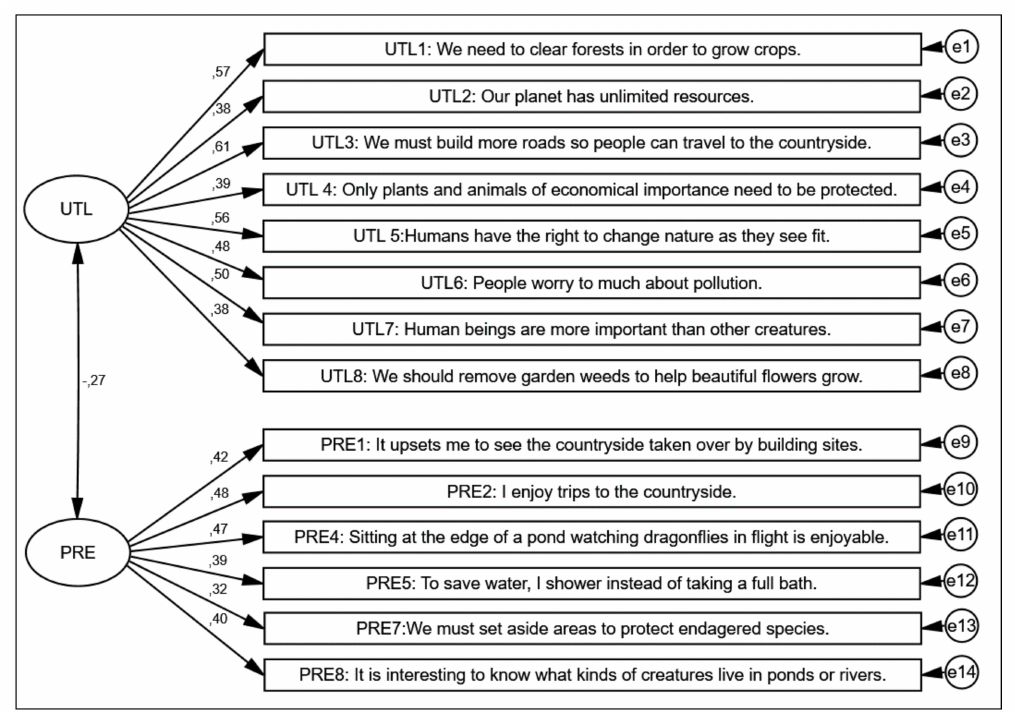
Figure 2. Confirmatory factor analysis (CFA) of the 2-MEV with standardized factor loadings and covariance between the latent variables Preservation and Utilization. Model fit indices: χ 2 = 78.99, df = 76, χ 2/df = 1.04, p = 0.384, CFI = 0.985, RMSEA = 0.013. e = error.